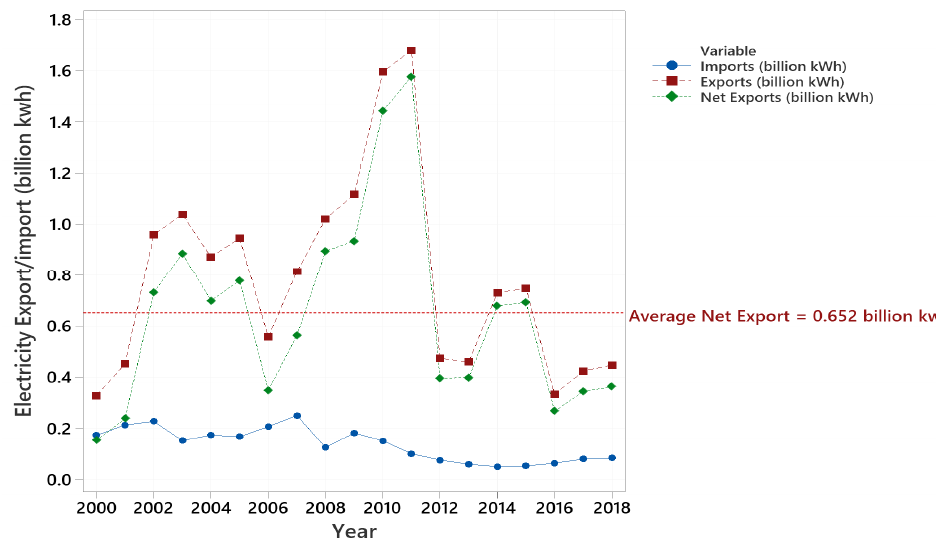
Figure 4. Historical data for net export of electricity for Egypt.